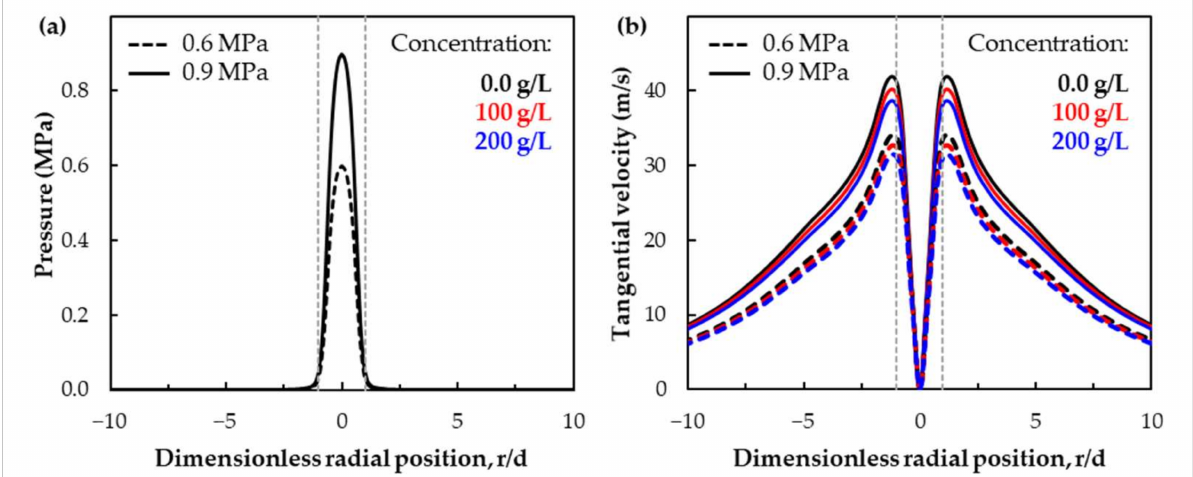
Figure 14. Numerical results of ( a ) wall pressure and ( b ) tangential velocity profiles of the liquid fluid flow. Liquid with different particle concentrations (0.0 g/L: black lines; 100 g/L: red lines; 200 g/L: blue lines). Pressure profiles are almost identical for different particle